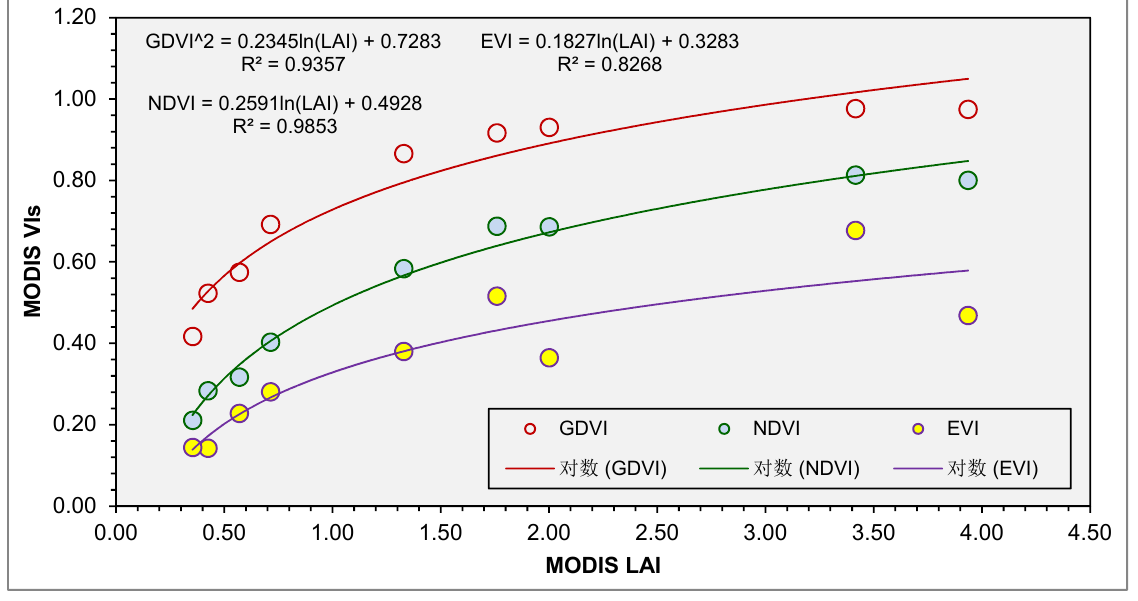
Figure 7. Relationships between MODIS Normalized Difference Vegetation Index (NDVI), Enhanced Vegetation Index (EVI) and GDVI and MODIS LAI (1 May